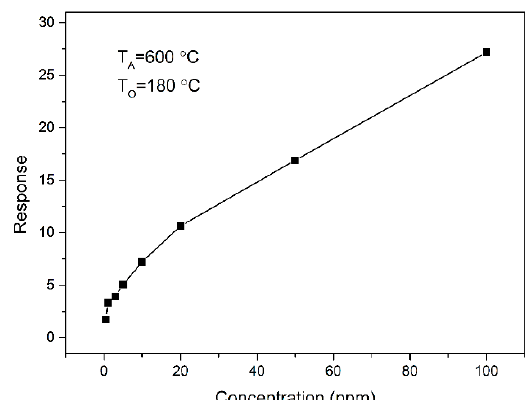
Figure 7. The response dependence on the acetone concentration for SnO 2 powders at the operating temperature of 180 °C. Table 2. Acetone sensing properties for various SnO 2 semiconductor sensors.